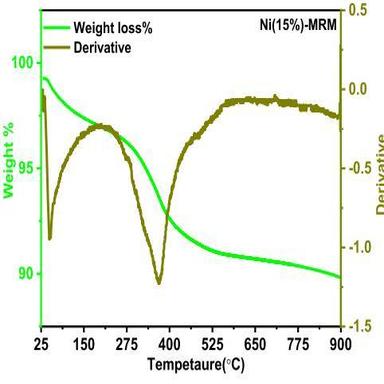
Thermogravimetric (TGA) and differential thermal analysis (DTA) of Ni (15 %)-MRM.